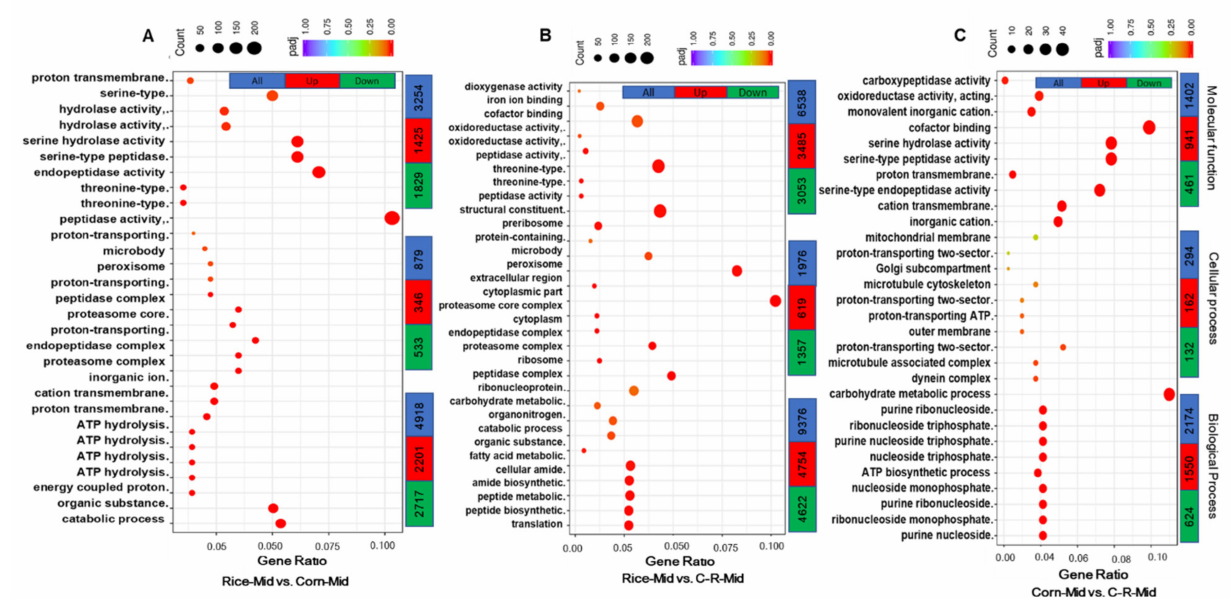
Figure 8. Gene Ontology (GO) classification of transcripts. The number of significantly up- and down-regulated unigenes are assigned into three main ontologies: biological process, cellular component and molecular function in the Rice-Mid vs. Corn-Mid ( A ), Rice-Mid vs. C-R-Mid ( B ) and Corn-Mid vs. C-R-Mid ( C ) (After 20 generation of selection the corn population was fed on rice for one generation (C-R-midgut)) of Spodoptera frugiperda when reared on corn and rice